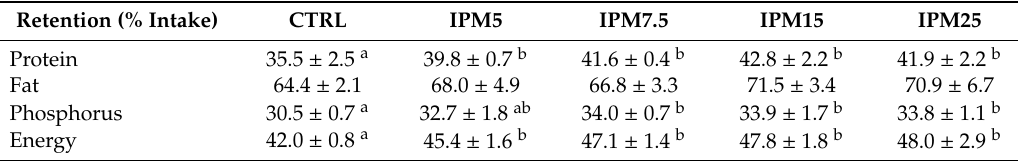
Table 4. Nutrient and energy retention in rainbow trout fed the five experimental diets (Control: CTRL, and experimental diets with 5%, 7.5%, 15%, or 25% insect protein meal (IPM), respectively IPM5, IPM7.5, IPM15, and IPM25). Values are means ± standard deviations ( n = 3). Di ff erent superscript letters indicate significant di ff erences ( p < 0.05) between experimental treatments.